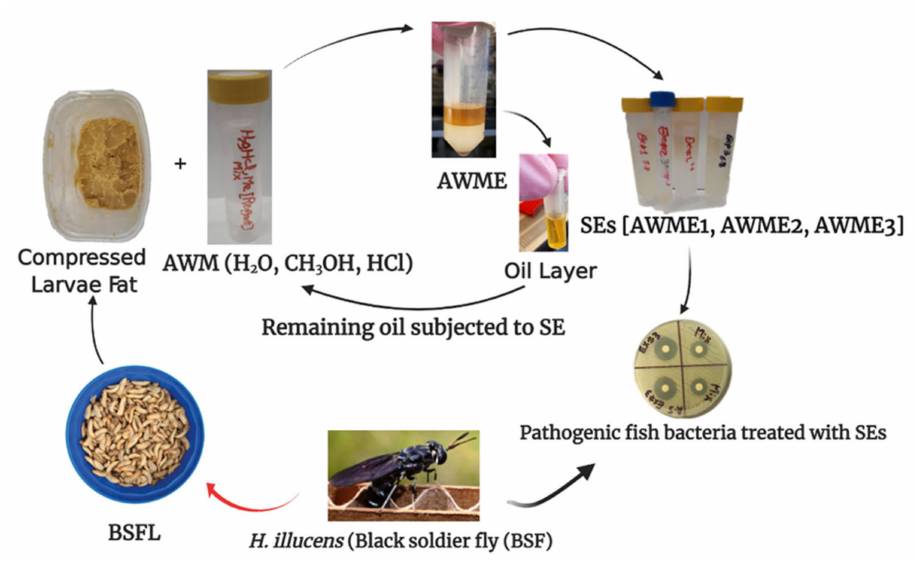
Figure 1. SEs stages of antibacterial compound isolation procedure from H. illucens larvae